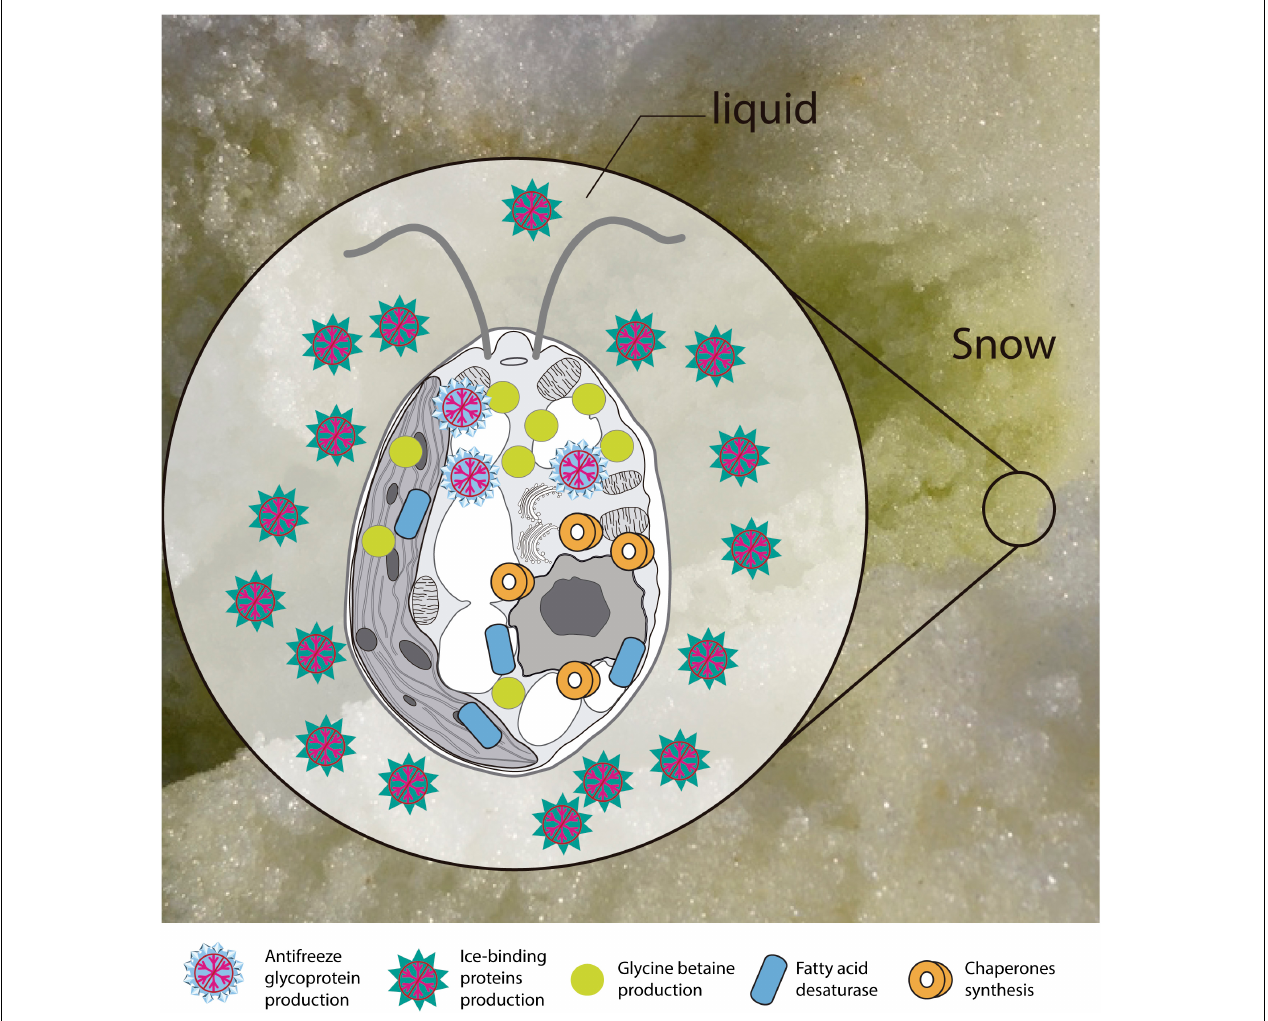
FIGURE 10 | Scheme of the main transcriptional responses at low temperature. Putative proteins and enzymes present in the Chlorominima collina CCAP 6/1 transcriptome are